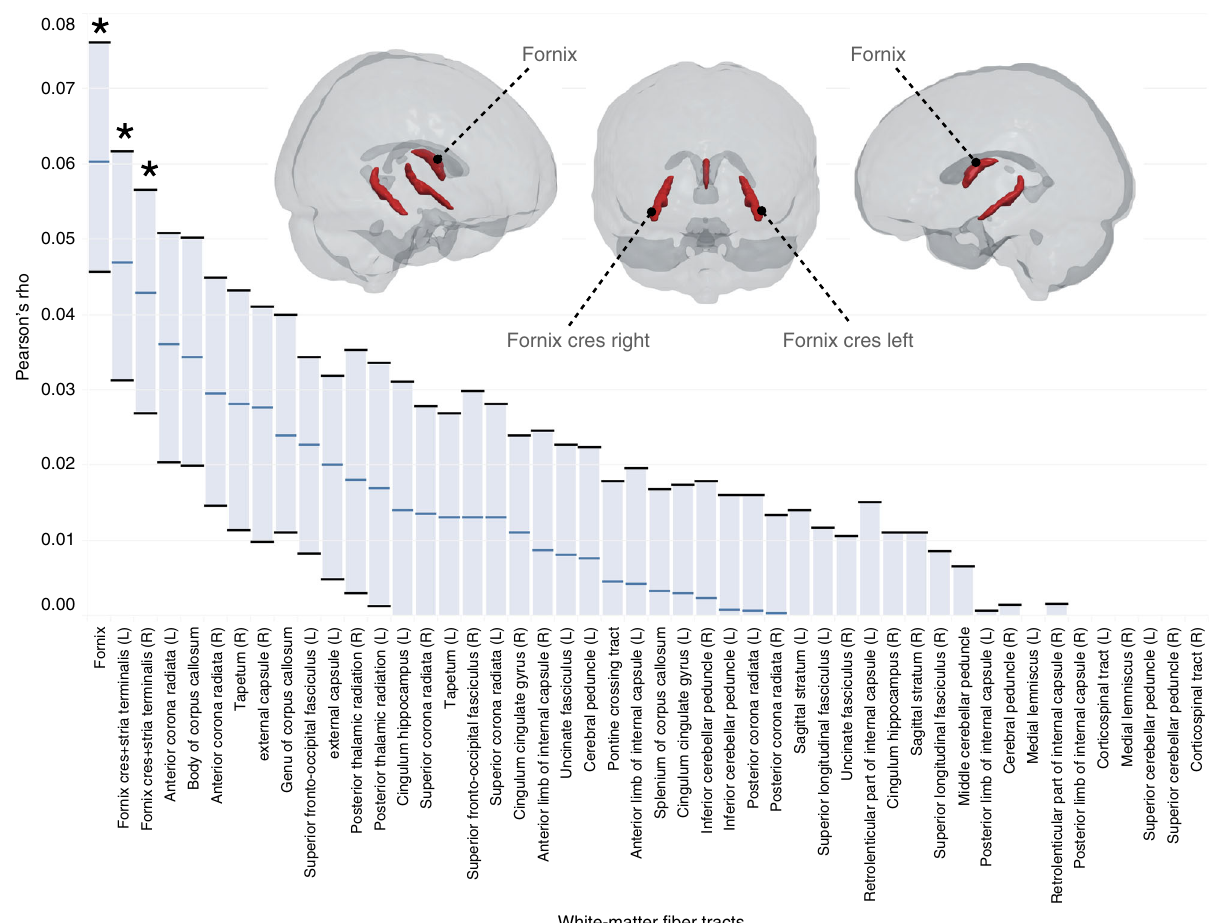
Fig. 3 Fornix fi bers emerging from the hippocampus are linked to loneliness. Among 48 examined major white matter tracts (ordered from strongest to weakest association), the top three fi ber bundles with relation to loneliness carried fornix fi bers (red) towards higher integrative brain areas including regions of the default network (tracts statistically signi fi cant at p < 0.001, after Bonferroni ’ s family-wise error correction, show asterisks). In addition to the obtained Pearson ’ s correlation rho between loneliness and tract microstructure (center of barplot), population intervals of 5 – 95% uncertainty (error bars) estimated the expected variation of this correlation effect size based on 100 bootstrap resampling iterations (cf. Supplementary Tables 4 – 6). L/R left/right hemisphere. The shown combination of Pearson ’ s correlation and bootstrapping was carried out in our whole UKB sample, but brain-loneliness associations held up to cross-validated out-of-sample testing in diffusion MRI (Supplementary Fig. 11). Source data are provided as a Source Data fi